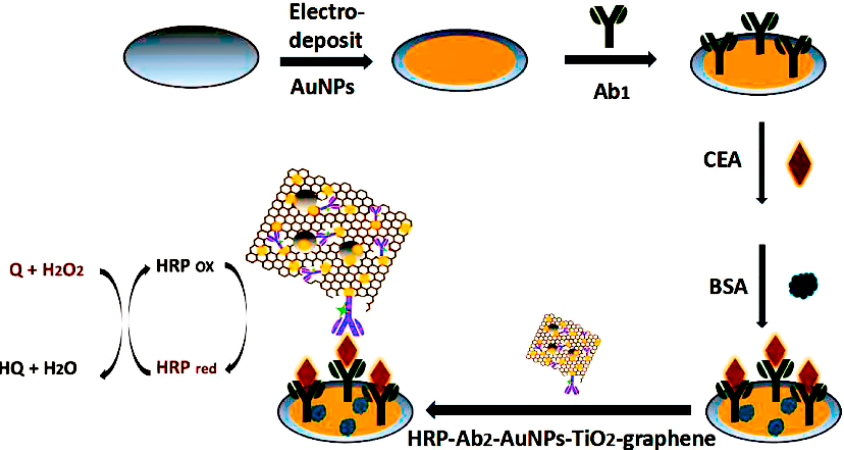
Figure 8. Schematic diagram of a CEA electrochemical immunosensor [89]. Copyright (2018) Elsevier.